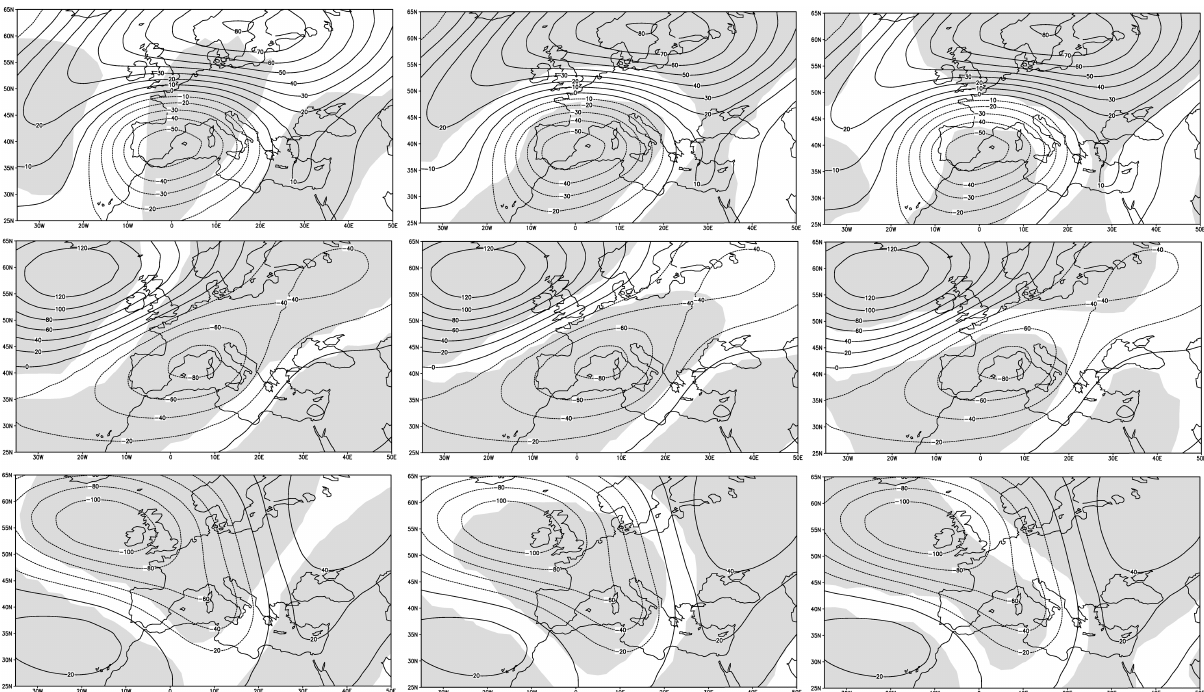
Fig. 5. Results of the Brunner-Munzel test applied to the three western Mediterranean Z500 clusters (one per row) during extreme precipi- tation days against Z500 clusters associated with dry days. Contour lines represent the centroids associated with extreme precipitation. The grey shadow denotes areas with significance ≥ 95%.